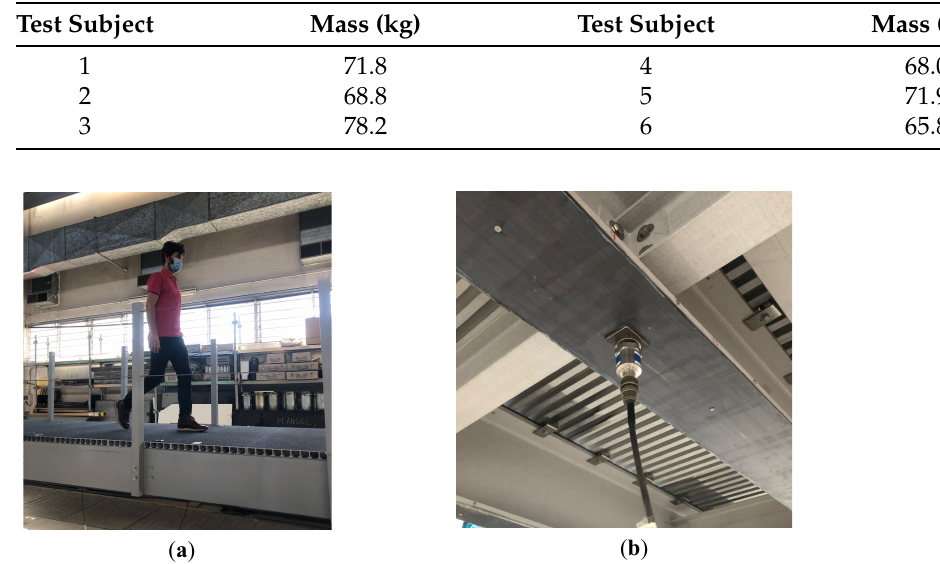
Figure 5. Experiment setup: ( a ) Third trial of Test Subject 2 crossing the bridge. ( b ) Accelerometer attached at the midspan of the central